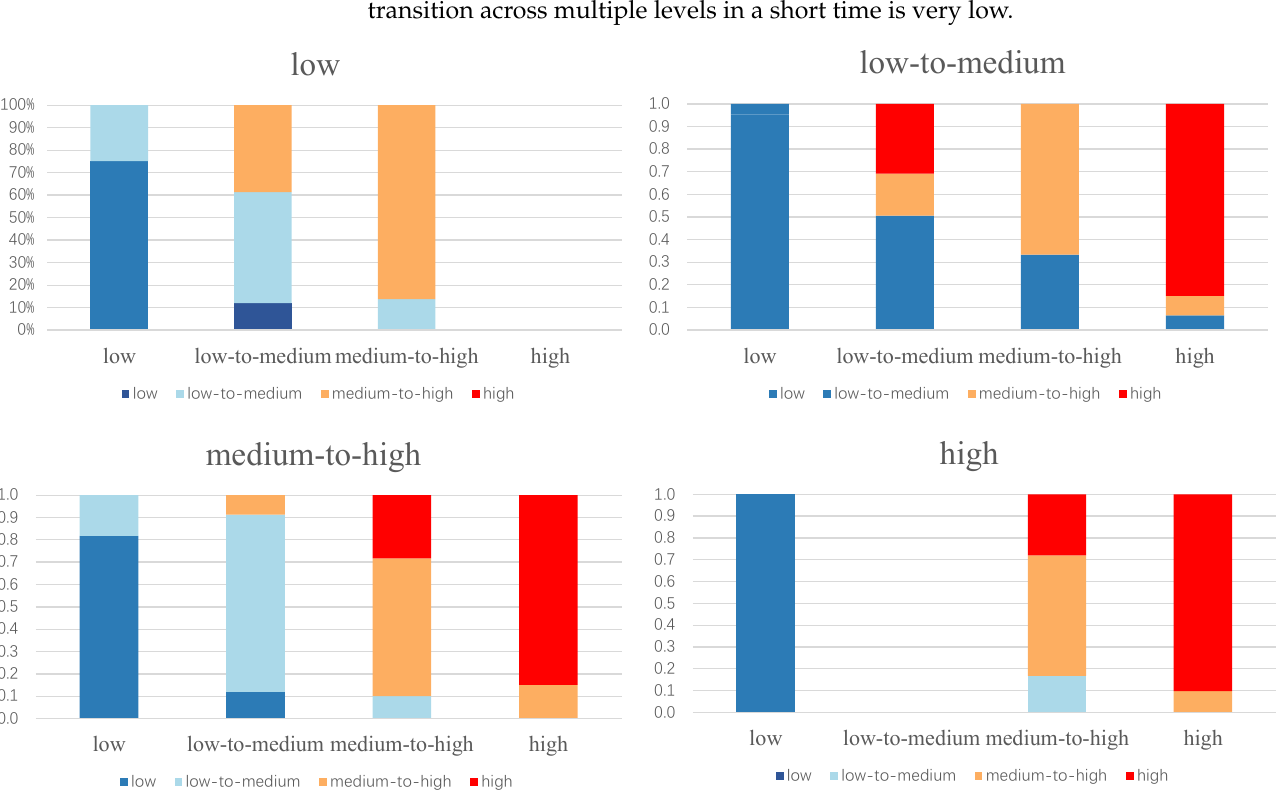
Figure 6. Spatial Markov matrix of the MSW treatment carbon emission efficiency in China during 2010–2019.